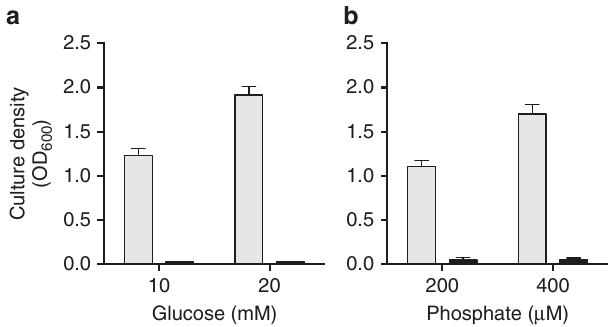
Fig. 2 Growth yield of P. aeruginosa in low-iron batch cultures. Individual cultures of the WT strain ( gray bars ) or the pvdS mutant ( black bars ) were grown in MEM for 24 h, and cell densities were measured as optical density at 600 nm (OD 600 ). The initial concentrations of glucose and phosphate in the medium varied as follows. In a , glucose varied while phosphate was held constant at 10 mM. In b , phosphate varied while glucose was held at 20 mM. The medium also contained 1 μ M Fe and 40 μ M of the chelator EDDHA that restricted growth of the pvdS mutant. Error bars show standard error of the mean (SEM), n =